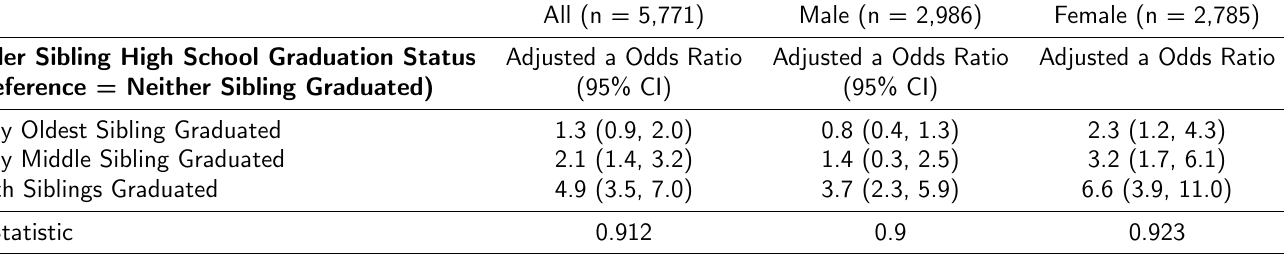
Table 2: Odds Ratios for High School Graduation of Youngest Sibling, for the whole population, and for males and females